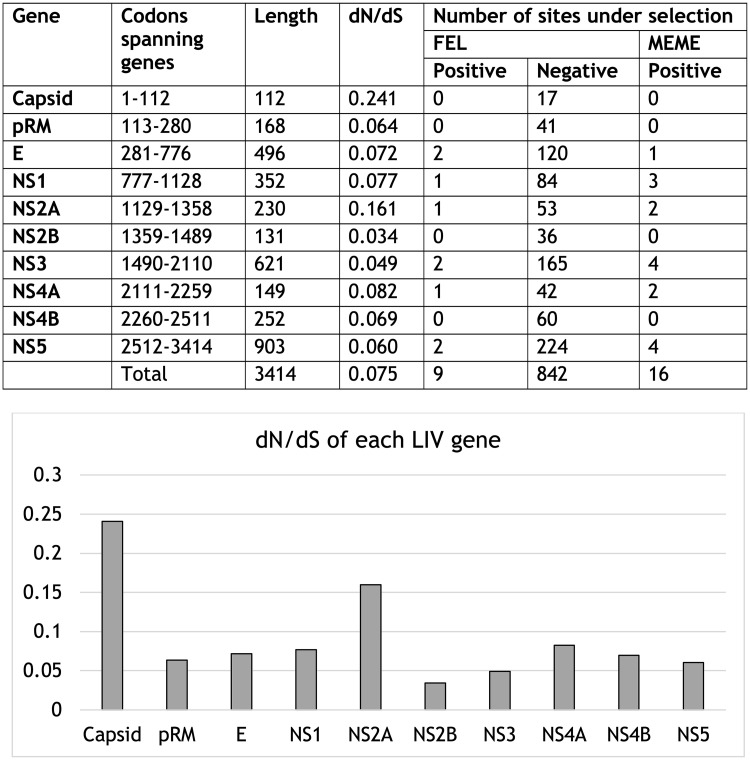
A) Gene by gene selection analysis of the 26 LIV genomes included in this study. dN/dS values are shown for each of the LIV genes. A dN/dS value of <1 is indicative of purifying selection. The number of sites under positive and negative selection was calculated using FEL and MEME analysis in the HYPHY software package as part of the DataMonkey web server. B) Graph of dN/dS values for each of the LIV genes.